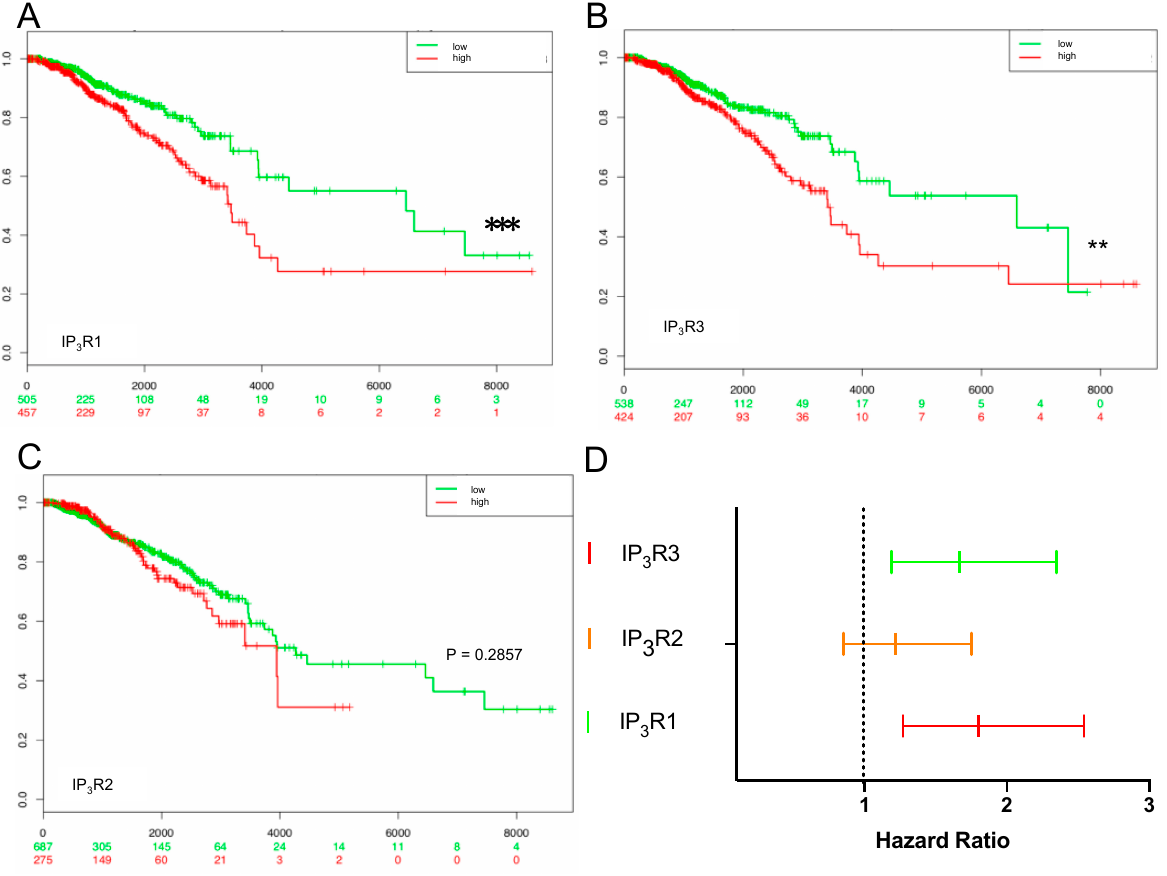
Figure 7. Analysis of the association between IP 3 R expression and overall survival, after application of the SurvExpress tool to the “ BRCA-TCGA Breast invasive carcinoma — July 2016 ” database (comprising 962 BC samples). ( A , B ) IP 3 R1 expression and IP 3 R3 expression were significantly associated with poor overall survival ( p = 0.0009 and p = 0.003). ( C ) IP 3 R2 expression was not significantly associated with poor overall survival ( p = 0.286). ( D ) The HR for each IP 3 R appears in an analysis of the “ Breast invasive carcinoma — July 2016” database. ** p < 0.01; *** p < 0.001.